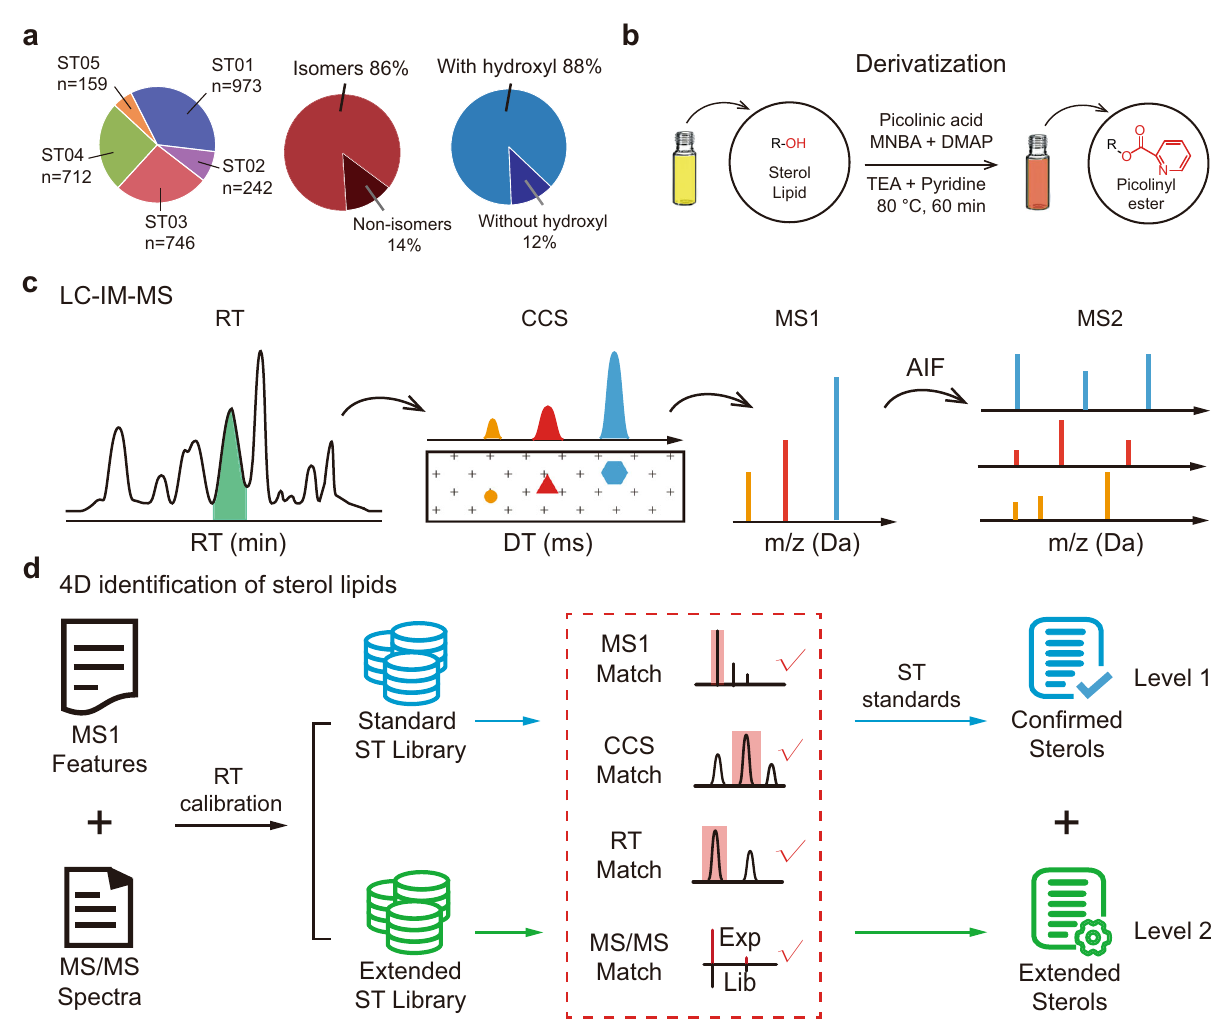
Fig. 1 Ion mobility-mass spectrometry technology for the four-dimensional analysis of sterol lipids. a Statistical analysis of sterol lipids in the LIPID MAPS Structure Database ( n = 2832). Left panel, numbers of sterol lipids in four main classes: ST01, sterols; ST02, steroids; ST03, secosteroids; ST04, bile acids, and derivatives; ST05, steroid conjugates. Middle panel, percentages of sterol isomers in the database. Right panel, percentages of sterol lipids with a hydroxyl group in the database. b Schematic illustration of picolinic acid derivatization. c Four-dimensional data acquisition enabled by liquid chromatography-ion mobility-mass spectrometry (LC-IM-MS). d Sterol identi fi cation by matching with the four-dimensional sterol